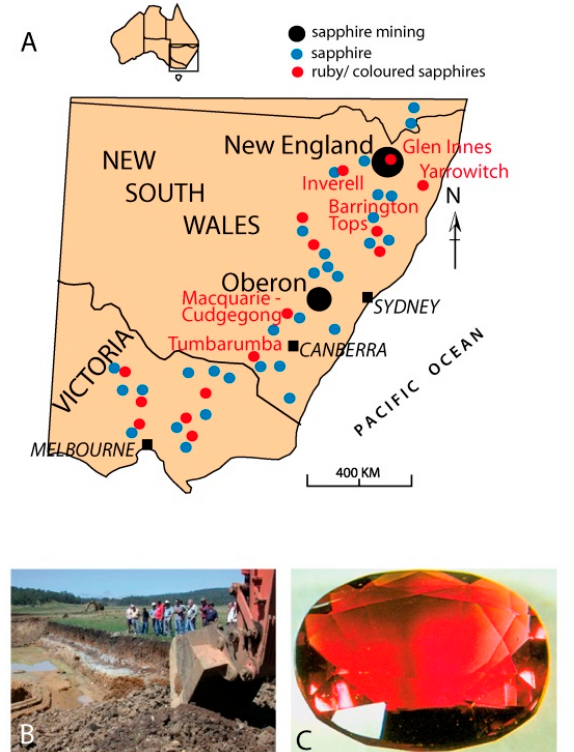
Figure 50. ( A ) Location of ruby deposits in New South Wales, modified after [81,86]; ( B ) opening of the Barrington Tops mine, March 2005, upper Manning flats. Photo: Cluff Resources Pacific M/L, Courtesy Lin Sutherland; ( C ) faceted 1 carat ruby, 6 x 4 mm across, Gloucester Tops, SE Barington Tops plateau. Photo. Gayle Webb.